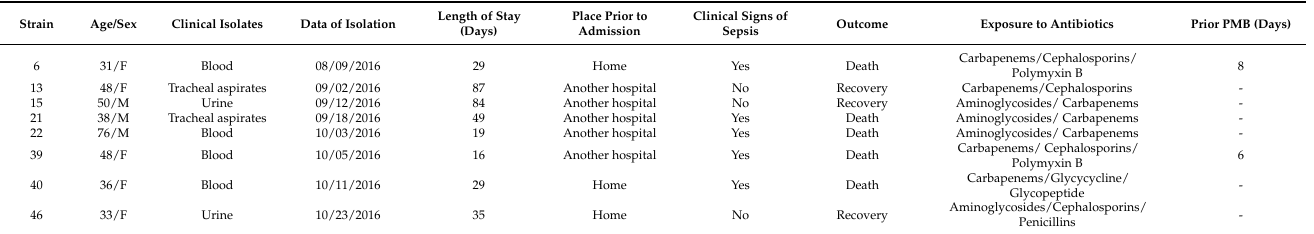
Table A1. Clinical characteristics of patients hospitalized in ICU and infected by polymyxin-resistant K. aerogenes .